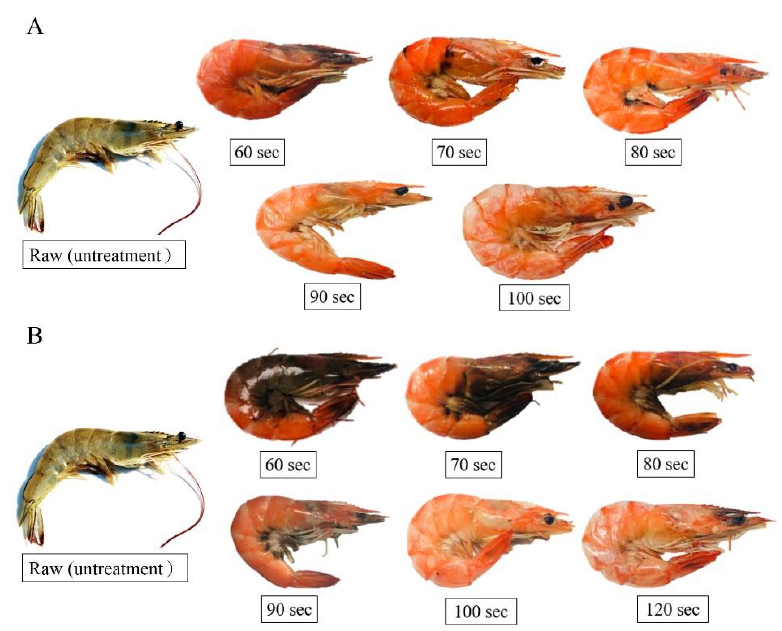
Figure 2. Appearance changes in white shrimp using microwave-assisted induction heating (MAIH) system set at 130 °C ( A ) and 90 °C ( B ) for different heating times.